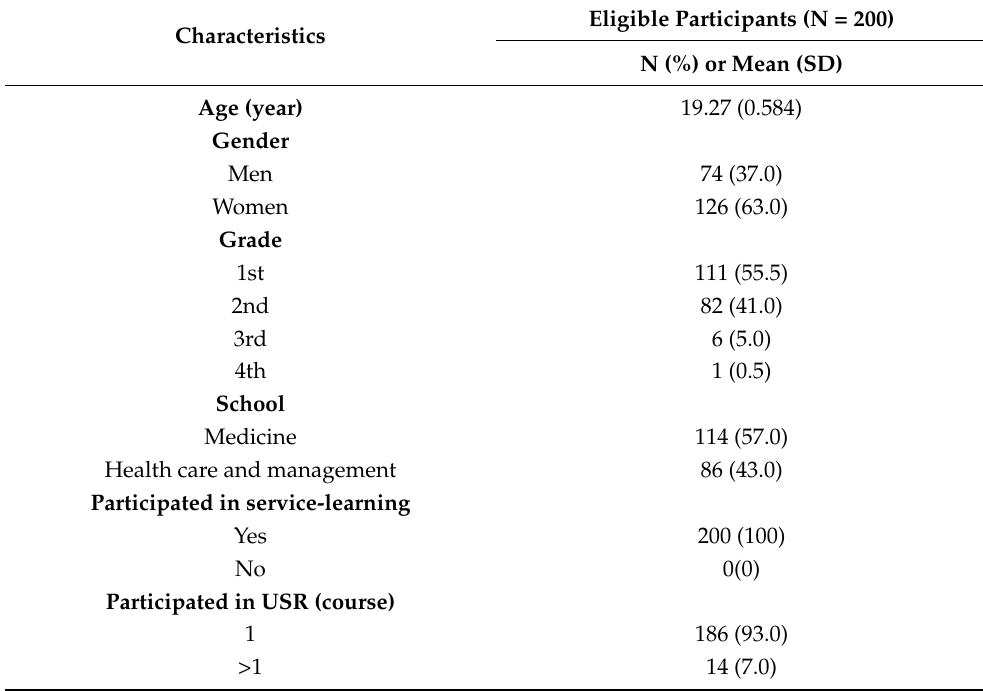
Table 1. Sociodemographic characteristics of the